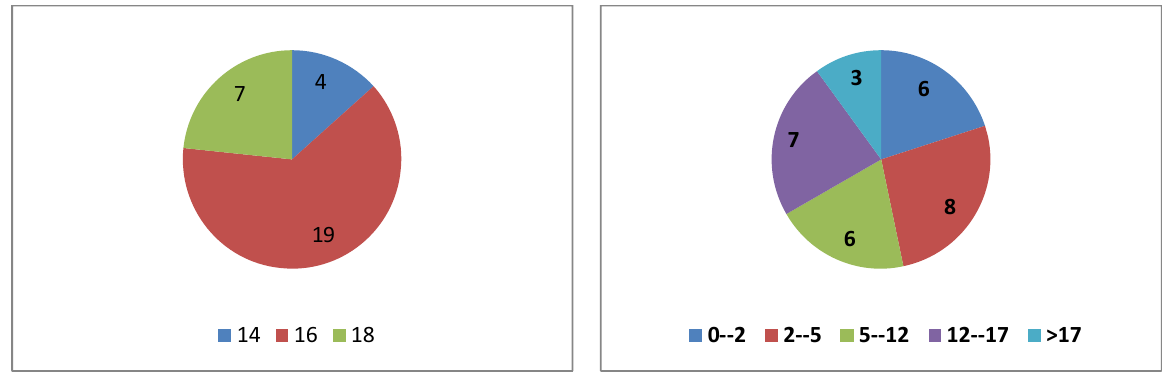
Fig. 2. Personal characteristics of the